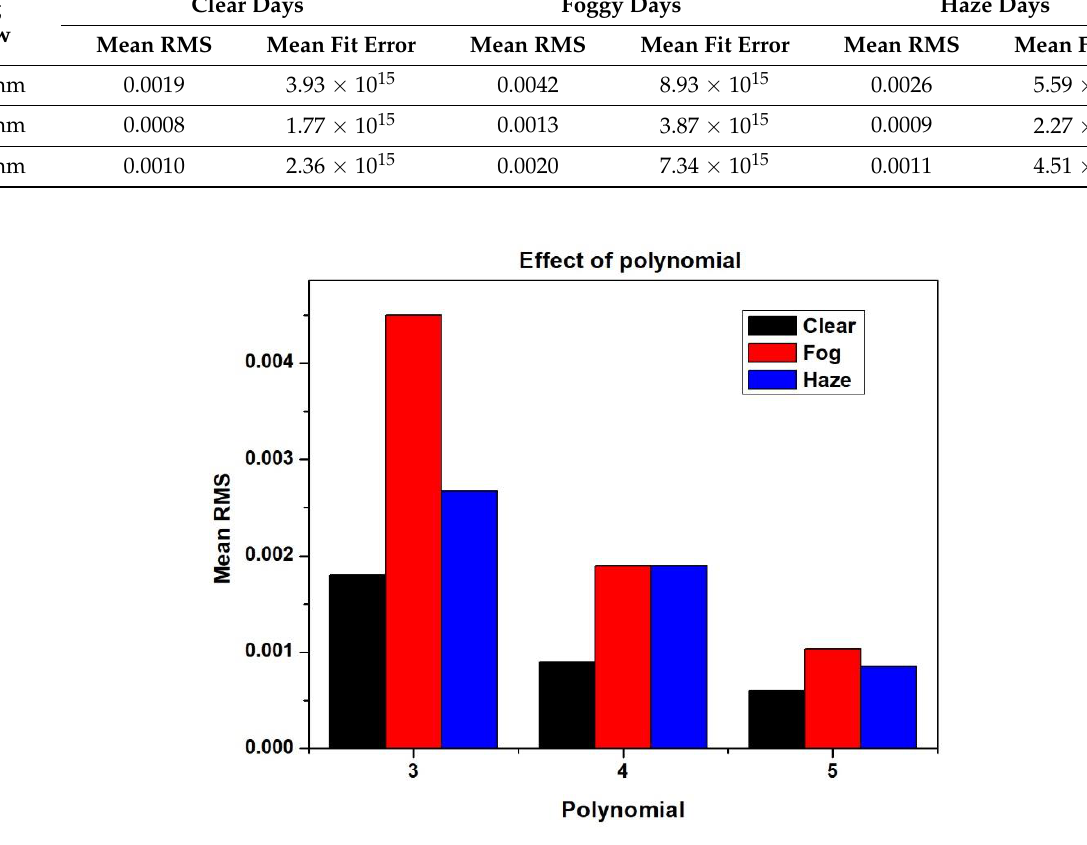
Figure 8. Effect of polynomial order on the mean RMS of SO 2 measured under different meteorological conditions.